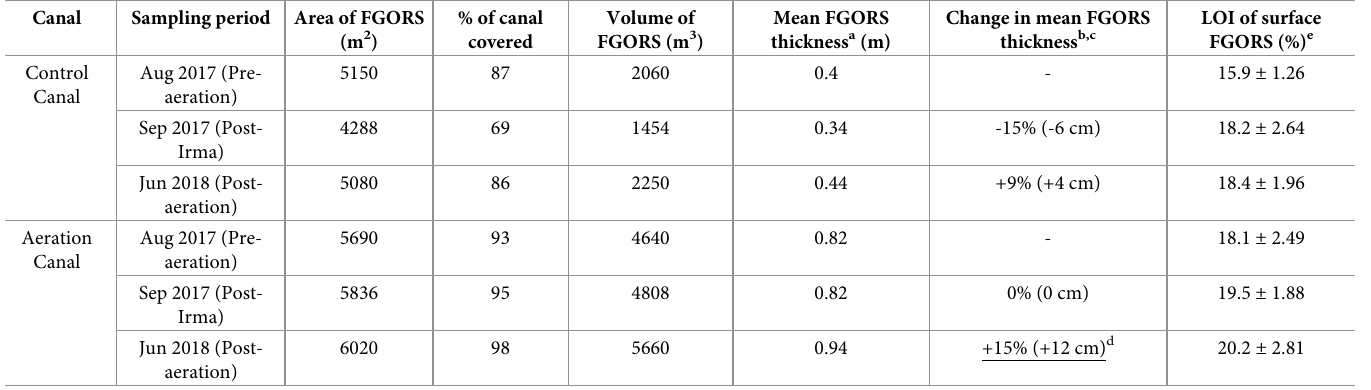
Table 3. Muck coverage (area), volumes of muck and Loss on Ignition (LOI) of surface muck layers in the control and aeration canals before aeration, after Hurri- cane Irma and after one-year of aeration. Canal Sampling period Area of FGORS (m 2